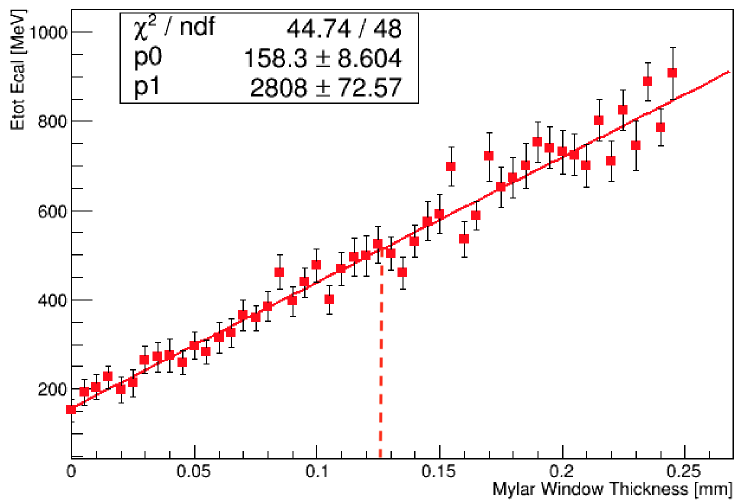
Figure 8 . Impact of the window thickness on the PADME experiment background energy deposi- tion for 25 × 10 3 POT using the 2020 beam line